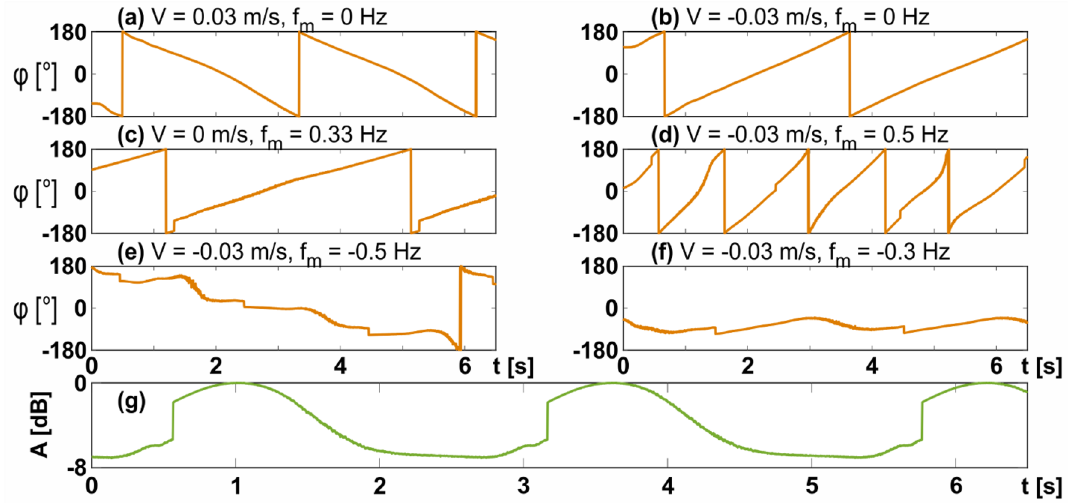
Figure 5. Analysis of moving targets—phases and amplitudes. V is the true velocity of the structure, f m is the temporal modulation frequency of the metasurface cover. ( a–e )—Profiles of the temporal phases retrieved by the radar for various real velocities and metasurface modulation frequencies f m (negative modulation frequency corresponds to a receding phase slope). ( f ) Modulation frequency compensates the Doppler effect, causing an almost flat phase profile in time ( g ) The normalized temporal amplitude at the radar receiver for stationary target with modulation f m = 0.33 Hz